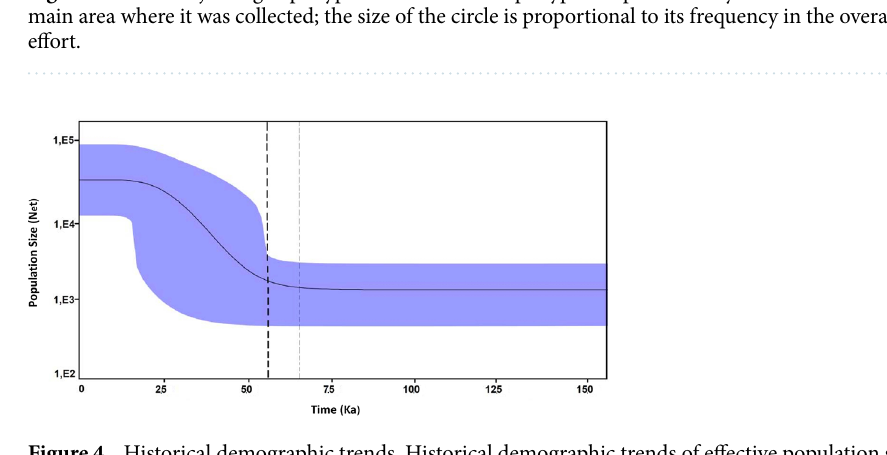
Figure 4. Historical demographic trends. Historical demographic trends of effective population size (Ne) constructed using a Bayesian skyline plot approach based on CoxI haplotypes. The y-axis is the product of effective population size (Ne) and generation length in a log scale while the x-axis is the time before present. The median estimate (solid black line) and 95% highest probability density (HPD) limits (purple area) are shown. The thick dashed line represents the time of the most recent ancestor, and the thin dashed line represents the time during which species expansion took